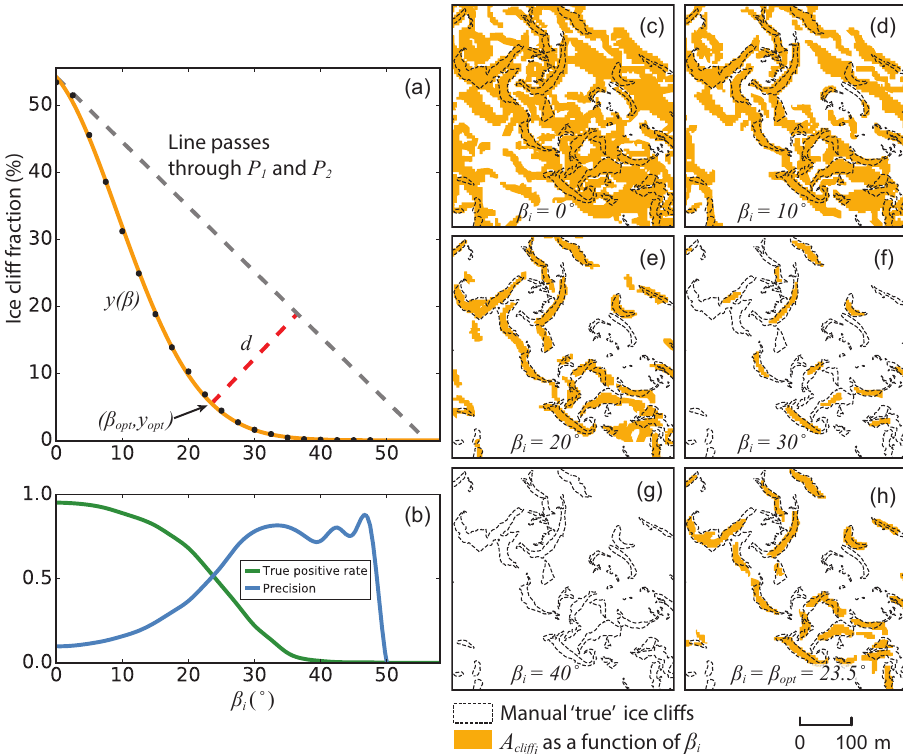
Figure 6. Panel (a) shows the heuristic method for selecting β opt . Black dots are computed values of the fraction of area ice cliffs occupy within the spatial domain for each β i in n number of iterations ( i ). The orange curve, y(β) , is a function fit to these points (Eq. 2). β opt is found by finding the longest distance, d , between y(β) and a line passing through points P 1 and P 2 (Eqs. 5 and 6). β opt is hypothesized to be coincident with the intersection of true positive rate and precision , the optimized, best possible balance of errors. (b) True positive rate and precision (derived in Sect. 3.5) comparing method results for each β i to “true” ice cliff area mapped from high-resolution optical and thermal data (Sect. 2.2.1). Panels (c–g) show the respective ice cliff maps ( A cliff ) for x axis ticks in panels (a) and (b) up to β i = 40 ◦ , with “true” ice i cliff area overlain for reference. Panel (h) shows the iterative method run a final time where β i = β opt and defines the automatically selected best ice cliff map. Location of panels (c–h) shown in Fig.